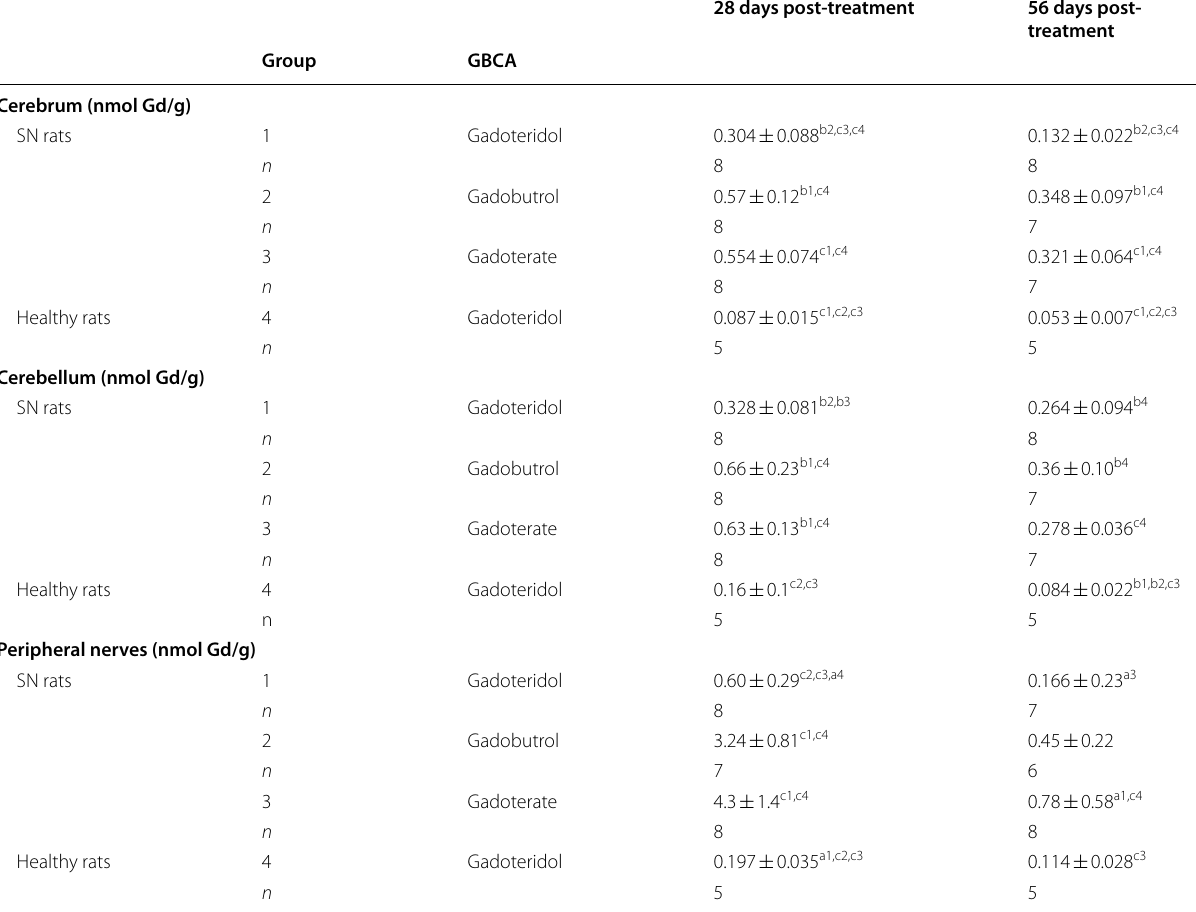
Table 1 Gadolinium content in the nervous